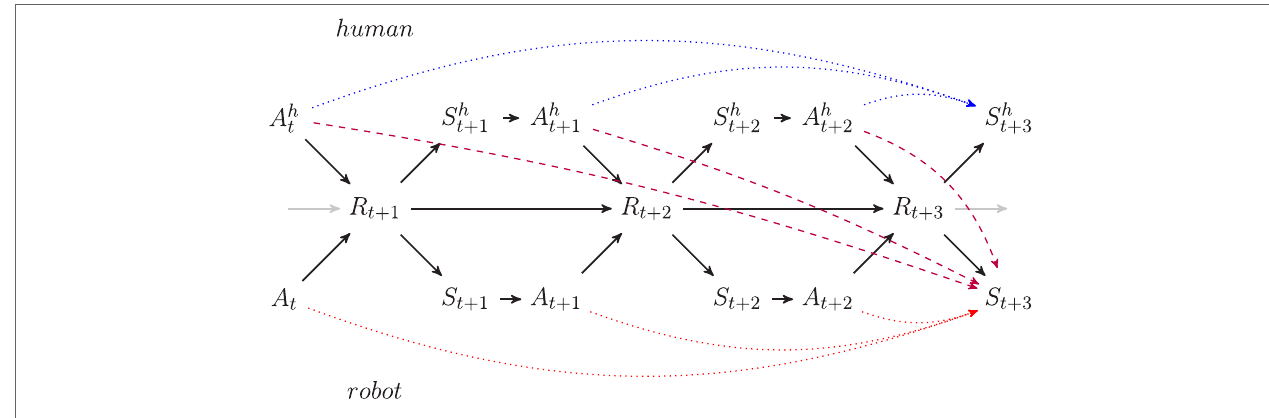
FiGUre 2 | The time-unrolled perception–action loop with two agents visualized as a Bayesian Network. S is the robot sensor, S h the human sensor, A is the robot actuator, A h is the human actuator, and R represents the rest of the system. The index t indicates the time at which the variable is considered. The arrows are causal connections of the Bayesian networks, the dotted and dashed line denote the three types of causal information flows relevant to the three types of empowerment discussed in the text. The red dotted arrows indicate the direction of the potential causal flow relevant for 3-step robot empowerment , the blue dotted arrows denotes human empowerment , and the dashed purple line indicates the human-to-robot transfer empowerment